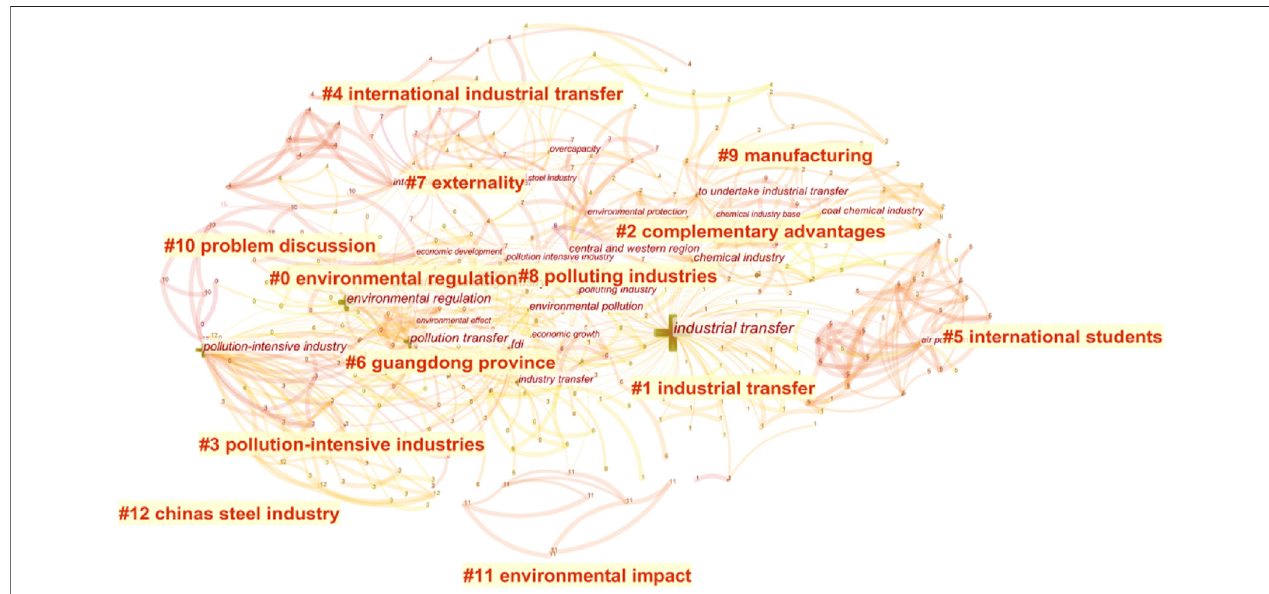
FIGURE 2 | Clustering view of keywords for the transfer of the pollution-intensive